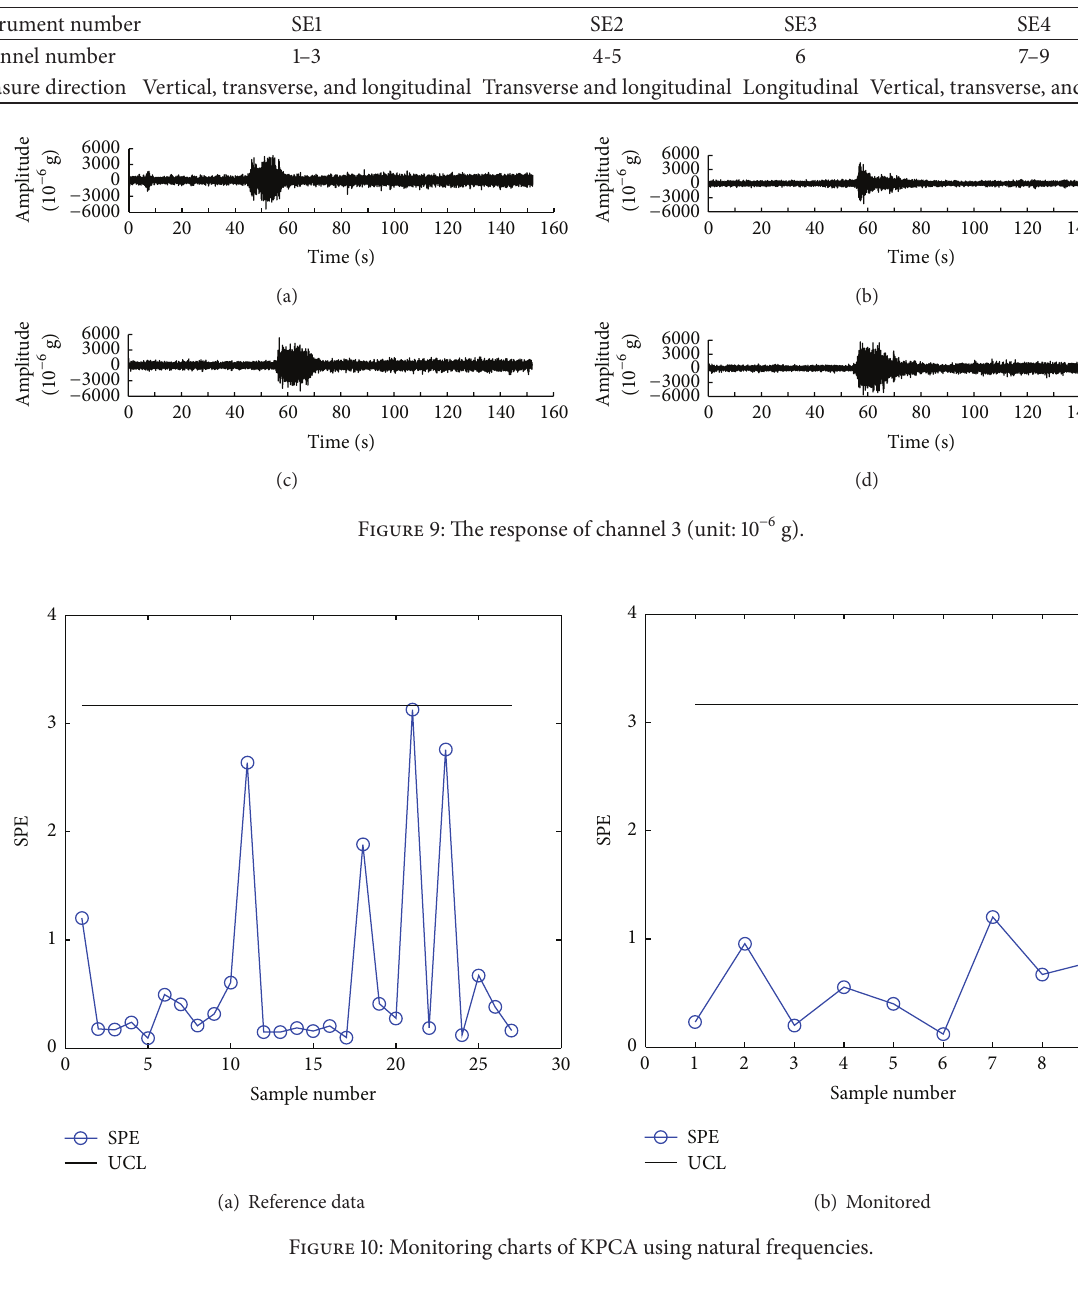
Table 2: Seismographs installed on dam block number 19.